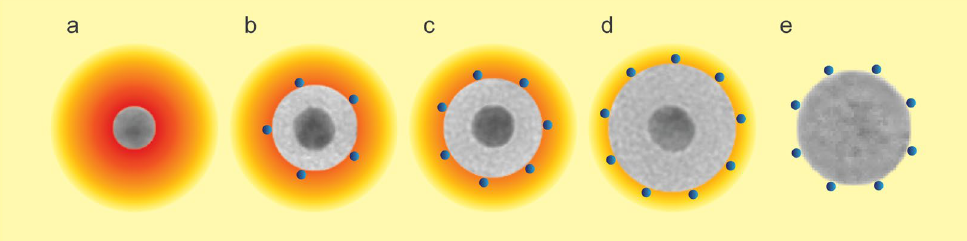
Figure 7. Cartoon of the field amplification around a GNP ( a ). PDI dyes on the surface of the gold-silica core-shell nanoparticles will feel a lower field amplification as the silica shell gets thicker (( b ) GNPSi7-PDI; ( c ) GNPSi9-PDI; ( d ) GNPSi13-PDI). Dyes on the surface of SiNP-PDI, used as reference, are not subject to field enhancement ( e